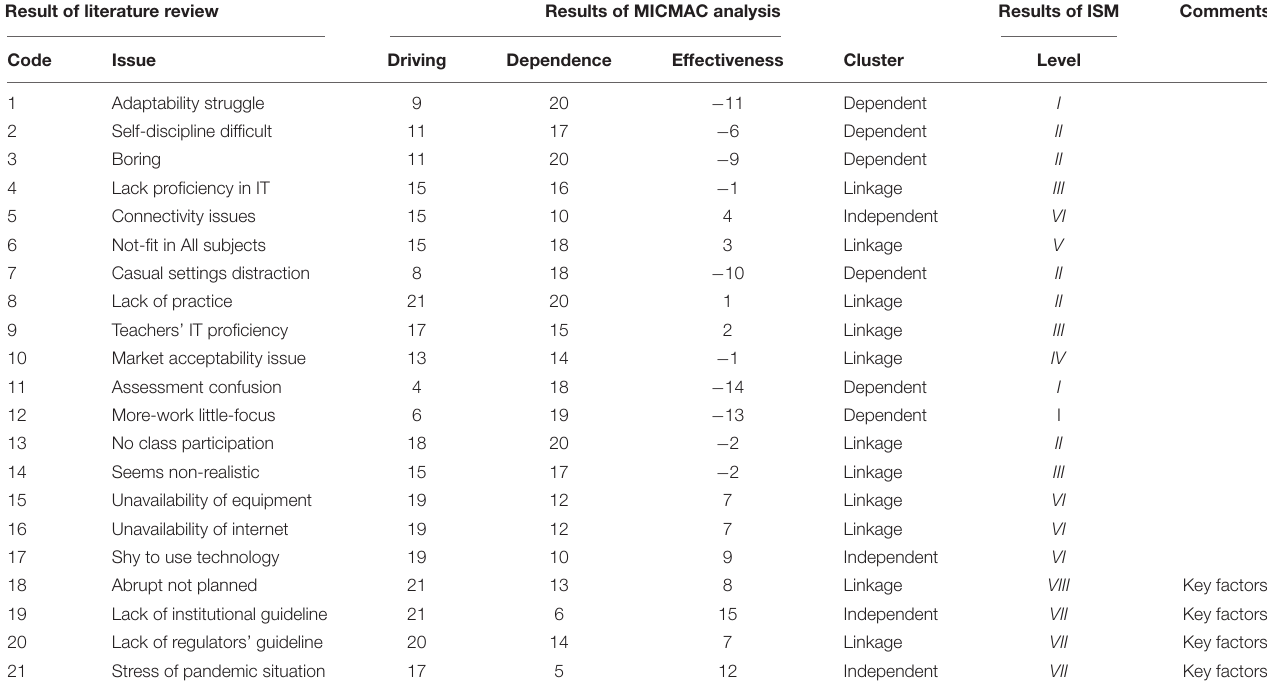
TABLE 5 | Juxtaposed results of literature, MICMAC, and